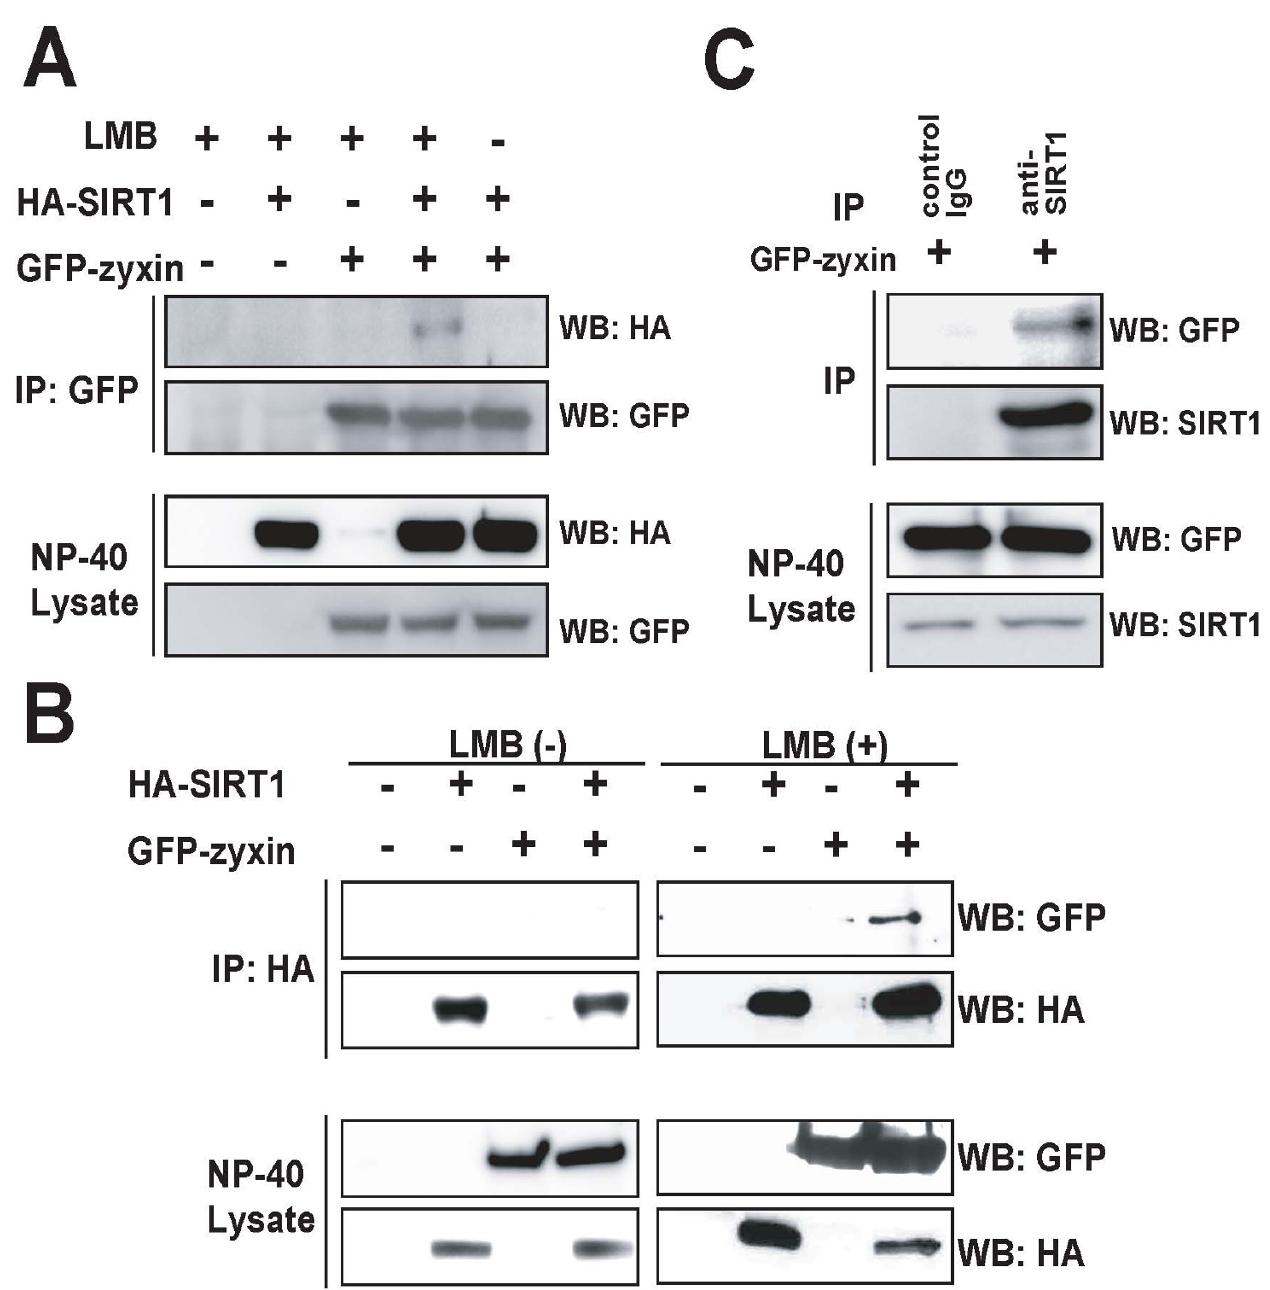
Figure 4 Interaction of SIRT1 with zyxin in mammalian cells . (A, B) Co-immunoprecipitation of SIRT1 and zyxin HEK293T cells transiently transfected with the indicated plasmids and treated with 20 nM of leptomycin B (LMB) for 6 h. Cell lysates were immunoprecipitated with the anti-GFP antibody (A) or anti-HA antibody (B). The immunoprecipitates were immunoblotted with a reciprocal antibody. (C) Endogenous SIRT1 interacts with GFP-zyxin. The lysates of HEK293T cells expressing GFP- zyxin were immunoprecipitated with anti-SIRT1 antibody or mouse IgG. The immunoprecipitates were immunoblotted with anti-GFP